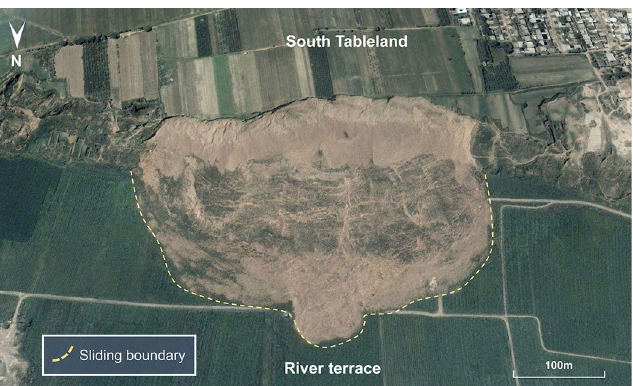
Figure 2. Morphology of a landslide after sliding near Dongfeng Village in July 2003. The sliding mass presents a flow-sliding state on the terrace and is spread across the terrace in a semicircular or circular shape.